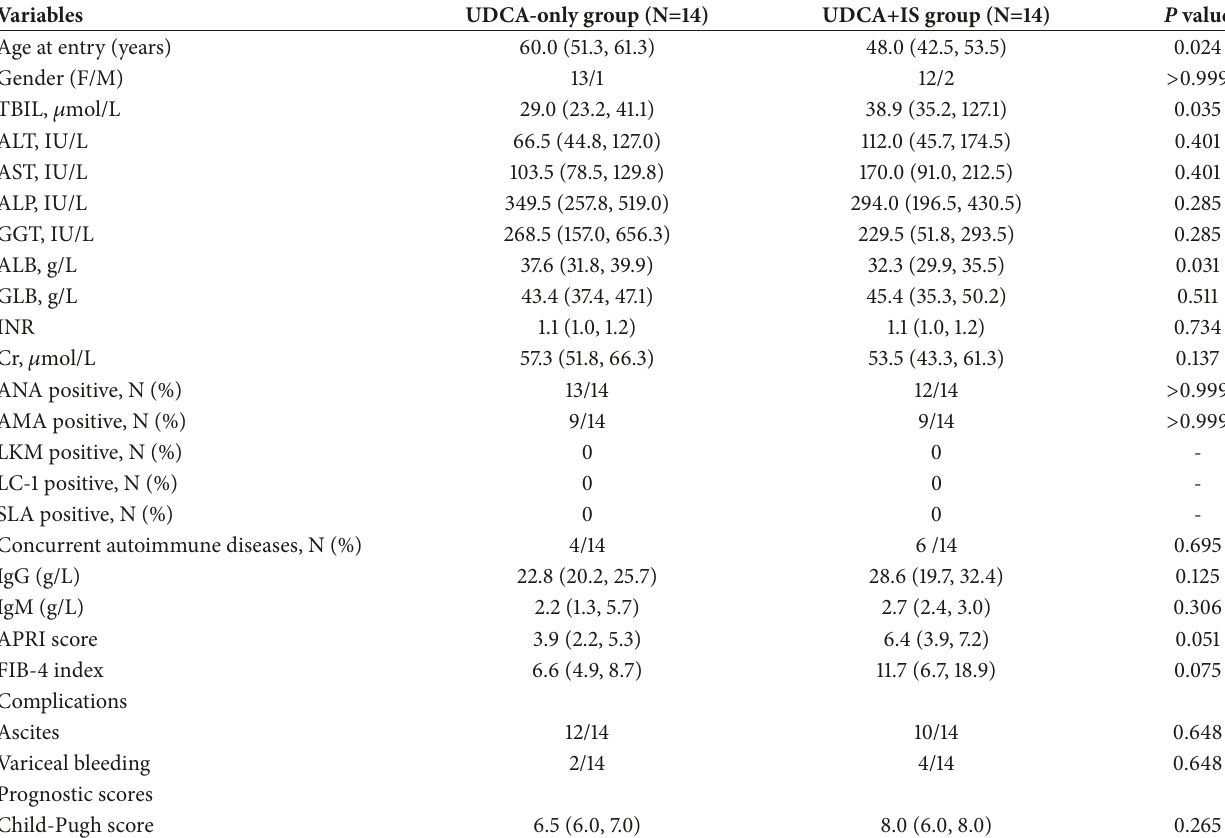
Table 1: Demographic and clinical features, laboratory parameters, prognostic scores, and decompensation characteristics between the two